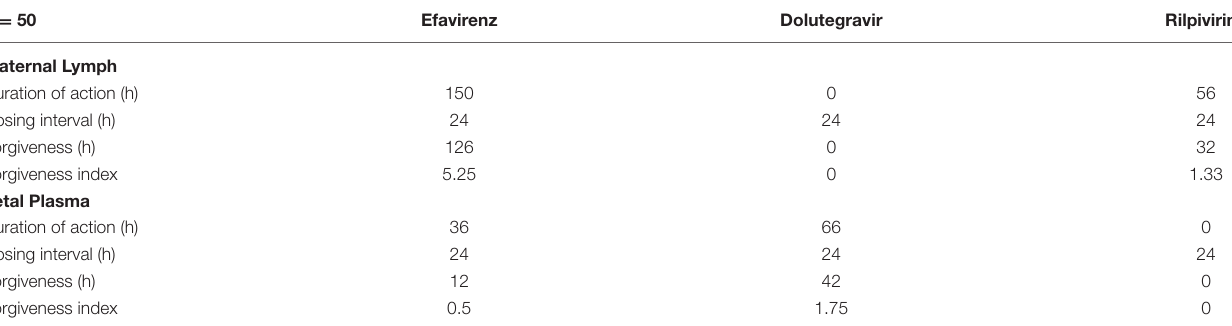
TABLE 6 | Predicted maternal lymph and fetal plasma dose forgiveness of 600mg efavirenz, 50mg dolutegravir and 25mg rilpivirine during third